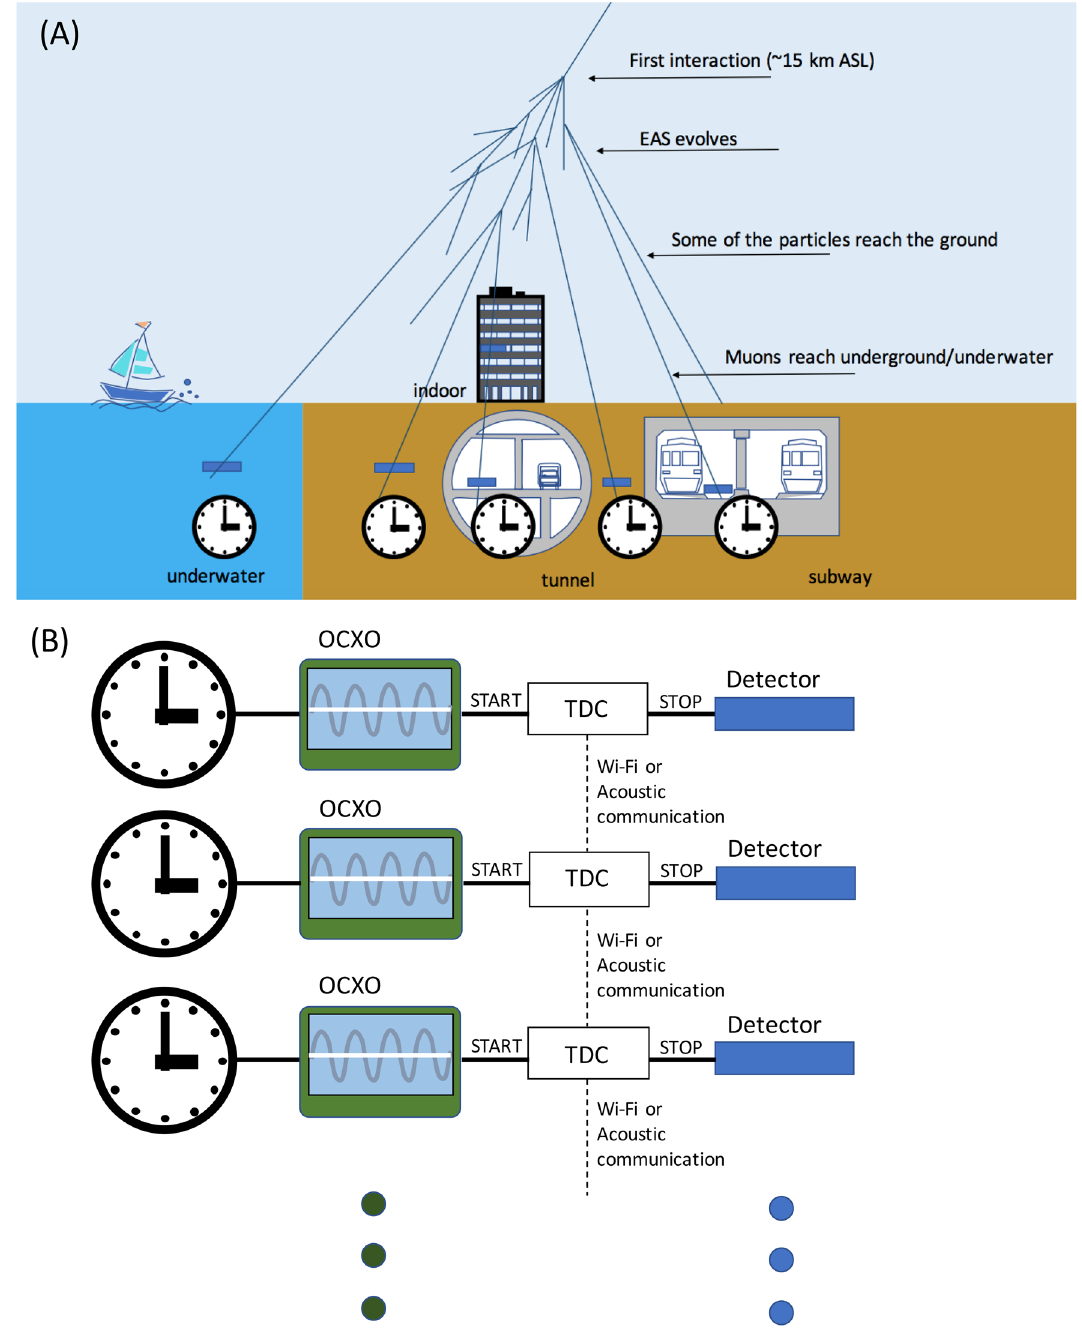
Figure 1. Principle of CTS. The overall CTS system configuration is shown with the EAS developments ( A ). The blue rectangular boxes indicate the CTS modules. The configuration of CTS modules is shown in ( B ). HKMT drew this image and holds the